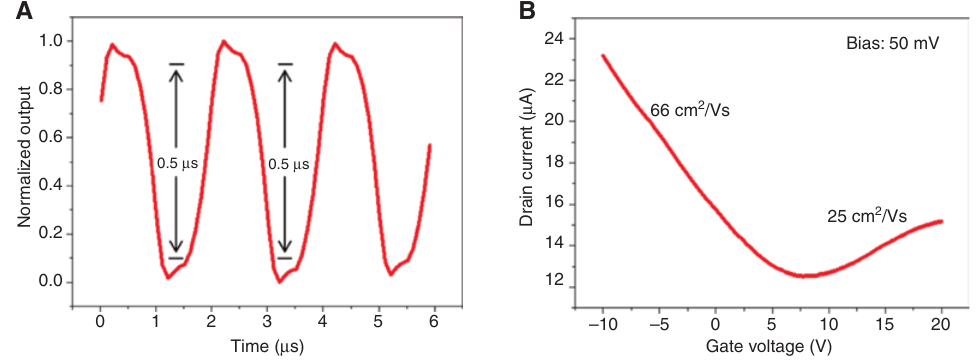
Figure 7: Photoresponse rate of the used CVD graphene material. (A) Normalized output signals of GPDs for pulsed optical signals. (B) Transfer curve of GFETs fabricated with same graphene as GPDs and carrier mobility of the graphene